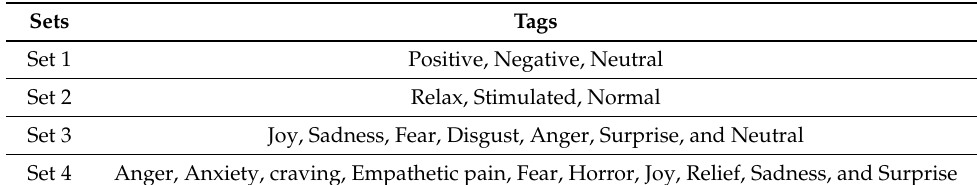
Table 2. List of tags used in the crowd-sourcing study in the four sets. Sets